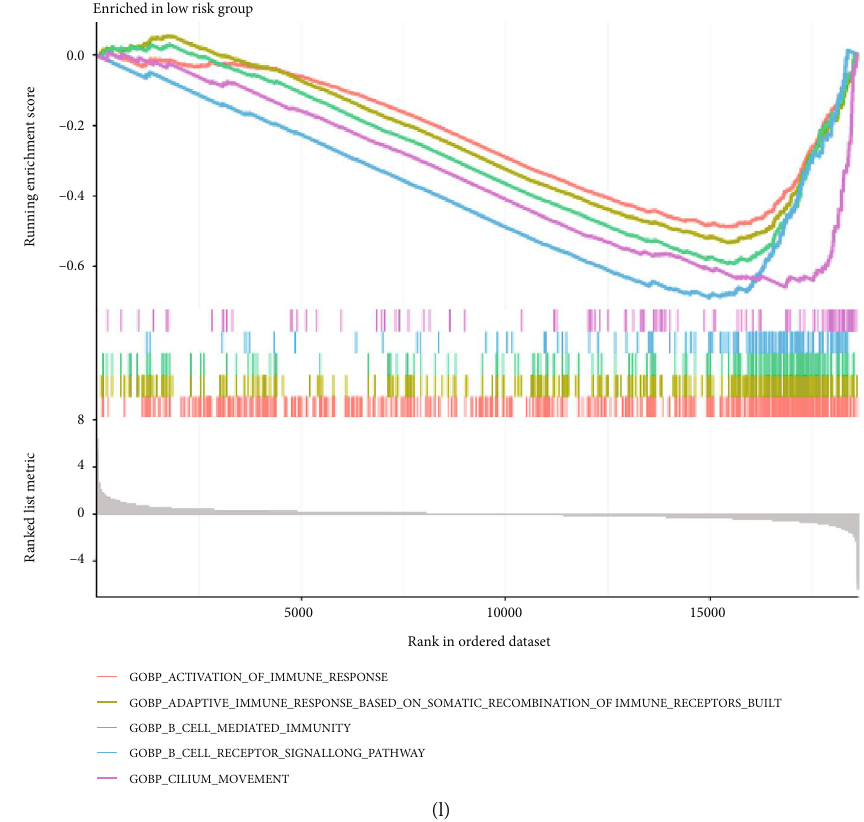
Figure 6: TMB, GSEA, and expression of HLA. (a) Expression of HLA in TCGA-LUAD cohort. (b) Expression of HLA in GSE72094. (c) TMB. (d) The landscape of genetic mutations of HR group. (e) The landscape of genetic mutations of LR group. (f) Survival analysis of risk score combined with TMB. (g) Evaluation of in fi ltration of cancer stem cells at RNA level. (h) Evaluation of in fi ltration level of cancer stem cells at DNA level. (i) KEGG of the HR group. (j) KEGG of the LR group. (k) GO of the HR group. (l) GO of the LR